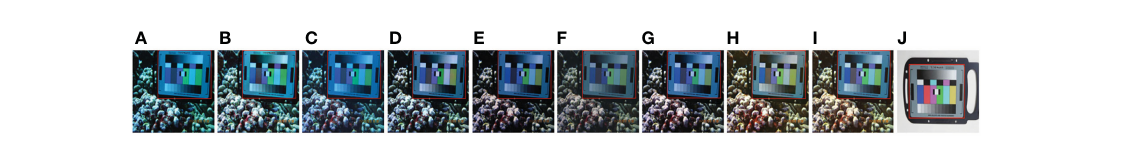
FIGURE 11 The visual results of the color accuracy test. From left to right, (A) shows the raw underwater images, (B – I) are the results of CLAHE (Pizer et al., 1990), OMGD (Ren et al., 2021), FUnIE-GAN (Islam et al., 2020), WaterNet (Li et al., 2019), UWCNN (Li et al., 2020), Shallow-UWnet (Naik et al., 2021), Spiral-GAN (Han et al., 2020) and the proposed model, respectively, and (J) shows the reference images.